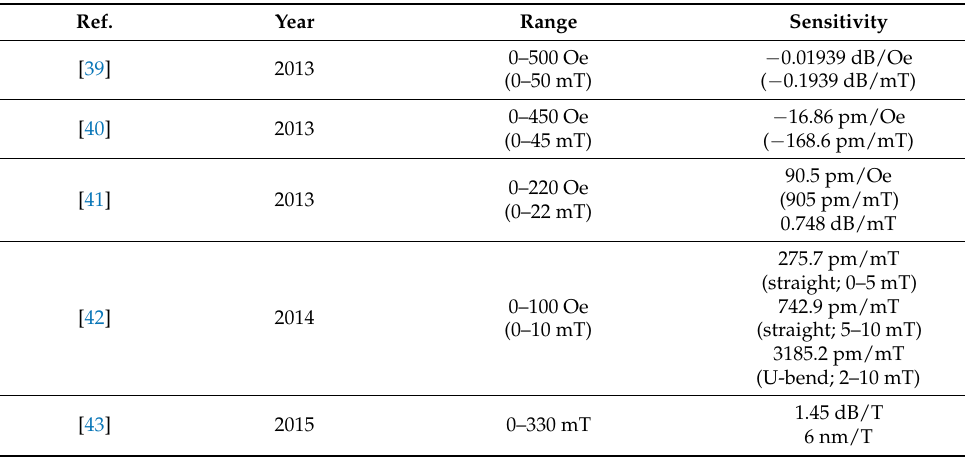
Table 2. Summary of the relevant parameters of MMI magnetic field sensors.